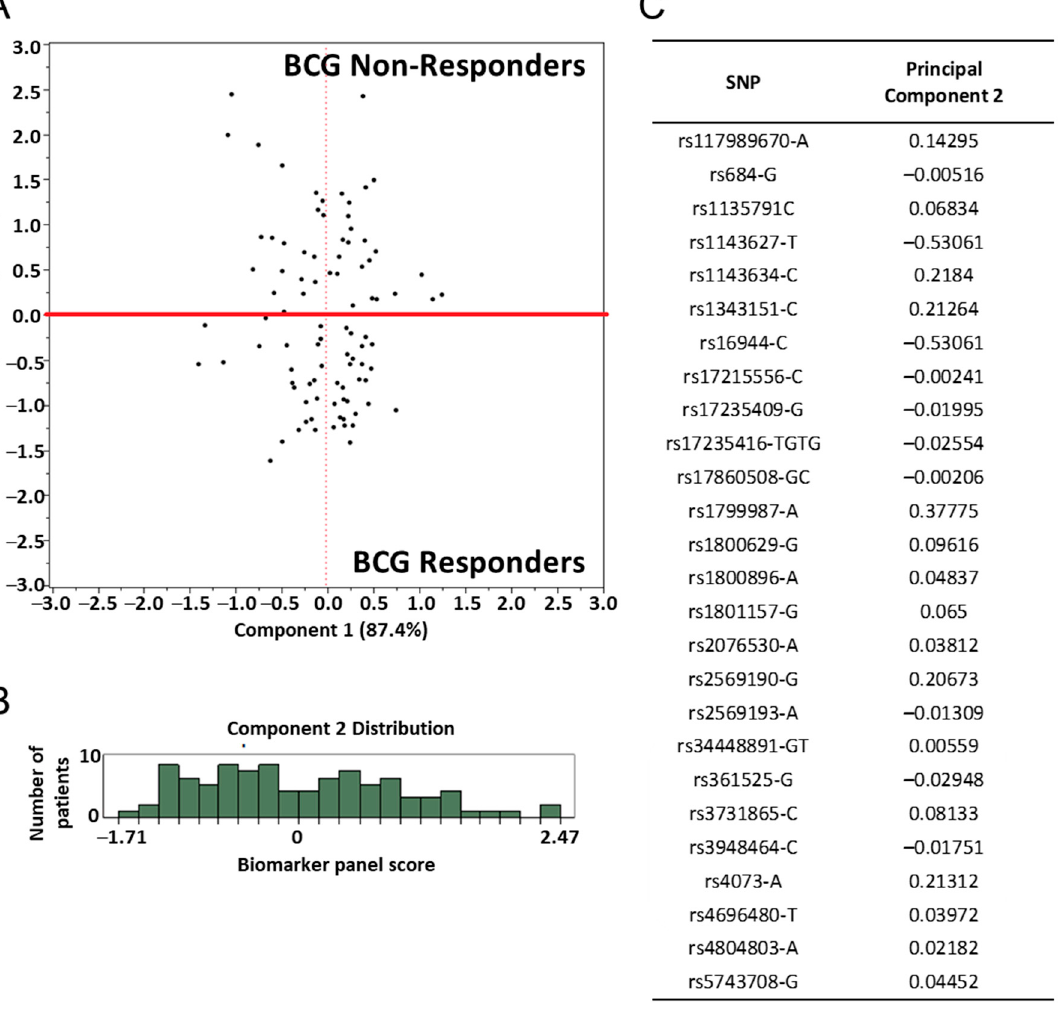
Figure 4. Principle component analysis (PCA) of gene SNP panel in the pilot patient cohort (MMAIT stage IV BCG-treated). ( A ) The gene SNP panel score for each patient is represented as a data point on principal component 1 and 2, representing the majority of the data variability. Red line = cut-off point at 0.005. ( B ) Histograms showing the distribution of principal component 2 among all patients. A cut-off point at component 2 was selected to dichotomize the patients into two groups, termed here as responders and non-responders. (Responders: Comp2 ≤ 0.005; Non-responders: Comp2 > 0.005) The cut-off point was selected at the point of separation in the data distribution. ( C ) The co-efficient for each gene SNP was determined by PCA. The alleles used for calculation of the co-efficient are